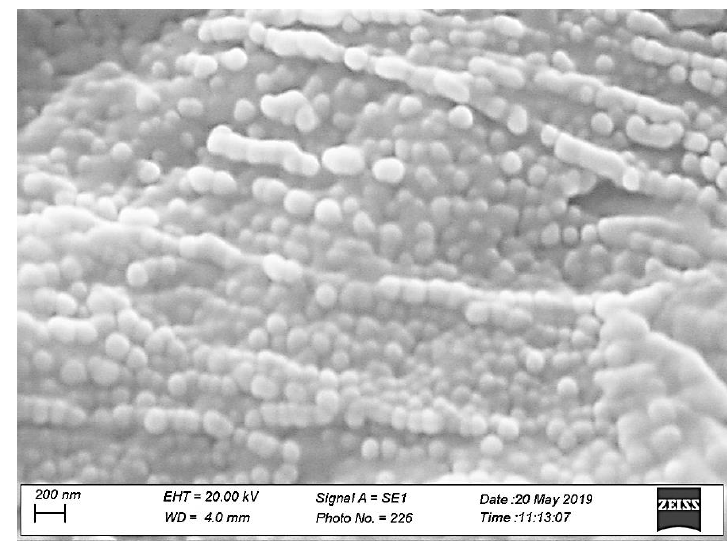
Figure 1. SEM morphology of CUR–NLC, showing the surface structure of the dried dispersion of CUR–NLC. Bar = 200 nm.